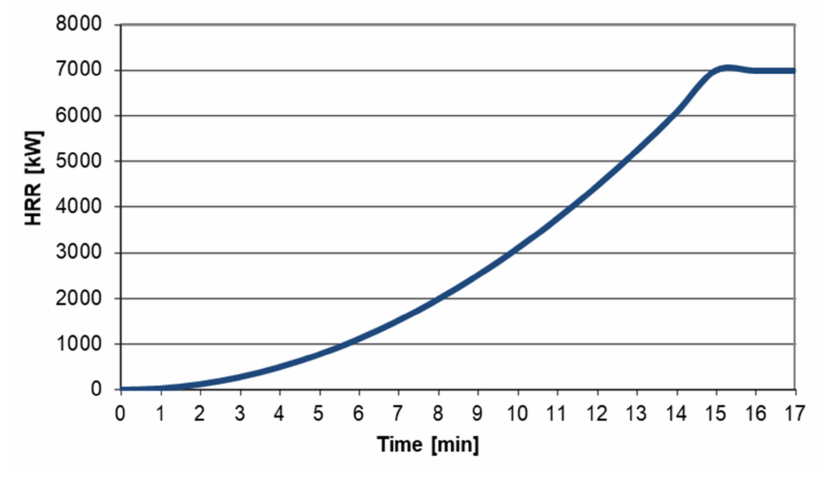
Figure 4. HRR curve of the